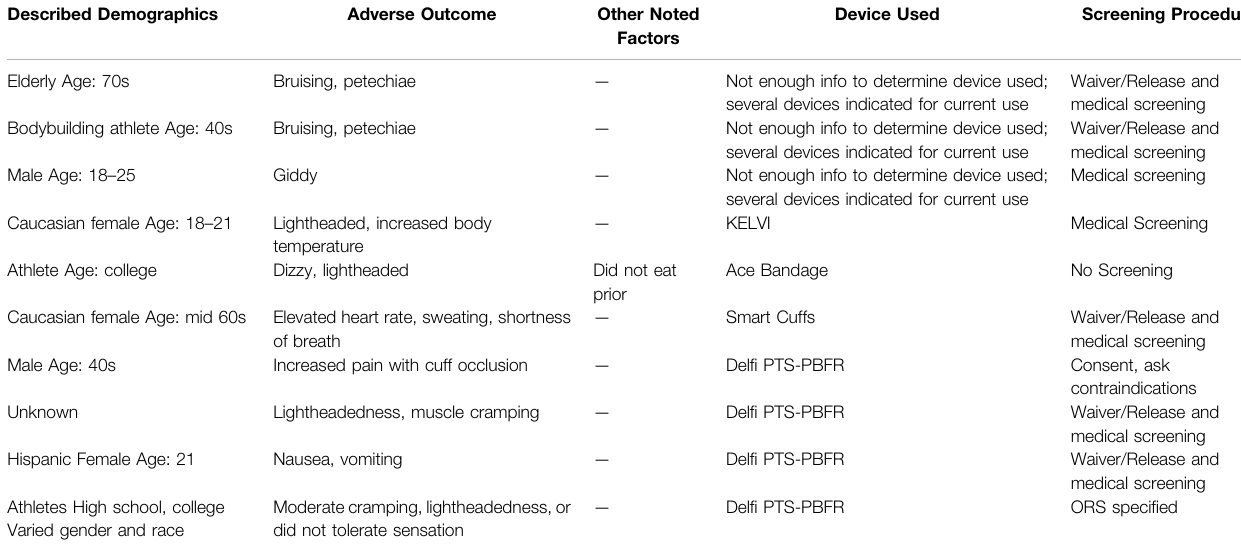
TABLE 5 | Adverse reactions described by respondents. Described Demographics Adverse Outcome Other Noted